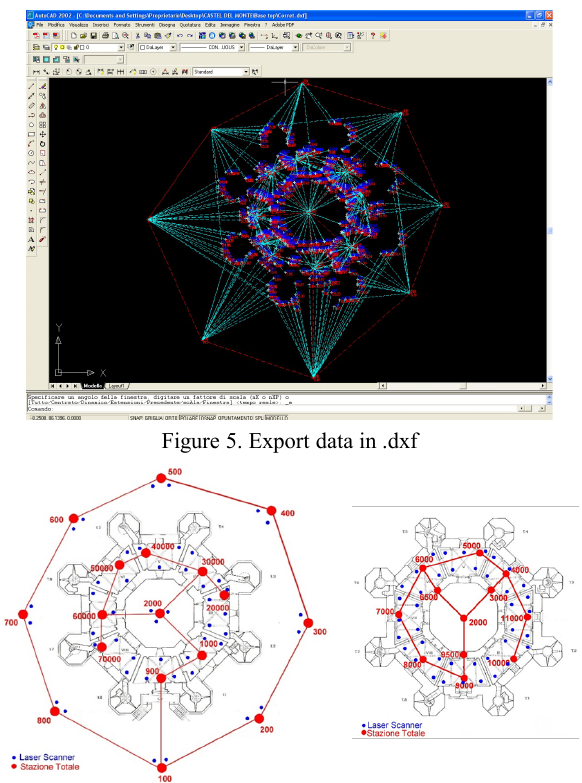
Figure 6. Topographical and laser scanners stations on the ground floor (left) and first floor (right)